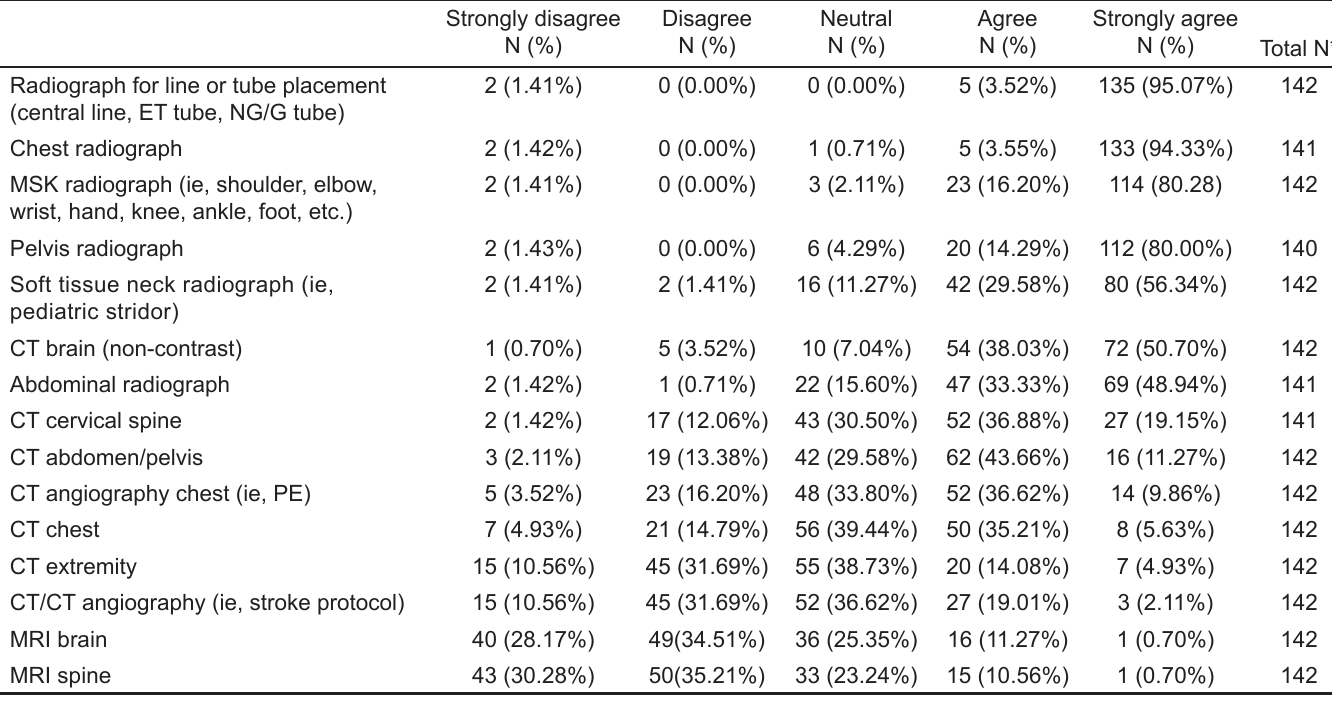
Table 4. Percentage of agreement with the following statement: “Residents should be able to independently interpret the following radiology study at